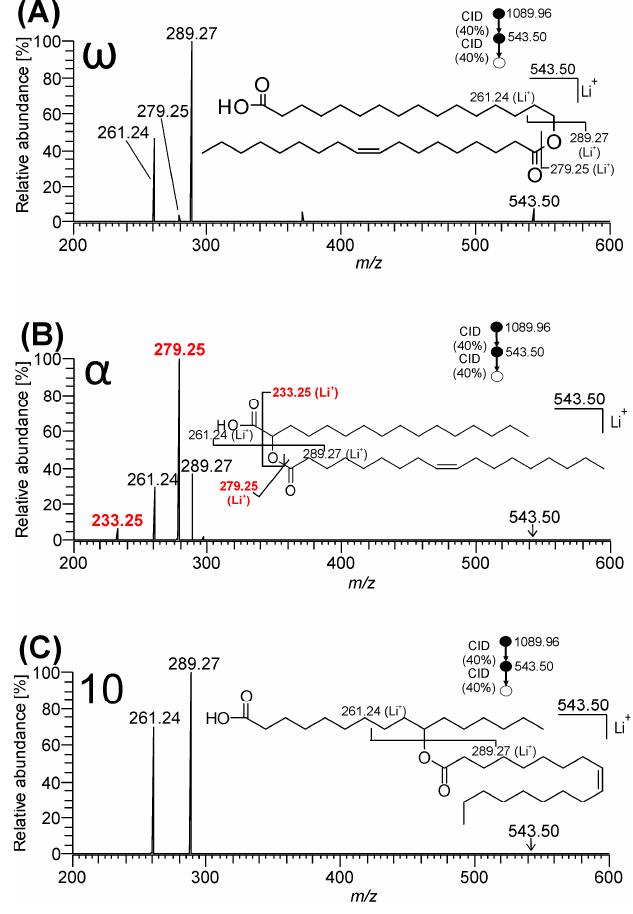
Figure 4. MS 3 CID/CID spectra of TG ‐ EST [M + Li] + . The product ion at m/z 543.50 arising from [M + Li] + was further fragmented: ( A ) TG ‐ EST 1 — ω‐ isomer; ( B ) TG ‐ EST 2 — α‐ isomer; ( C ) TG ‐ EST 3 — 10 ‐ isomer. Diagnostic fragment ions for the various positional isomers are highlighted in red.